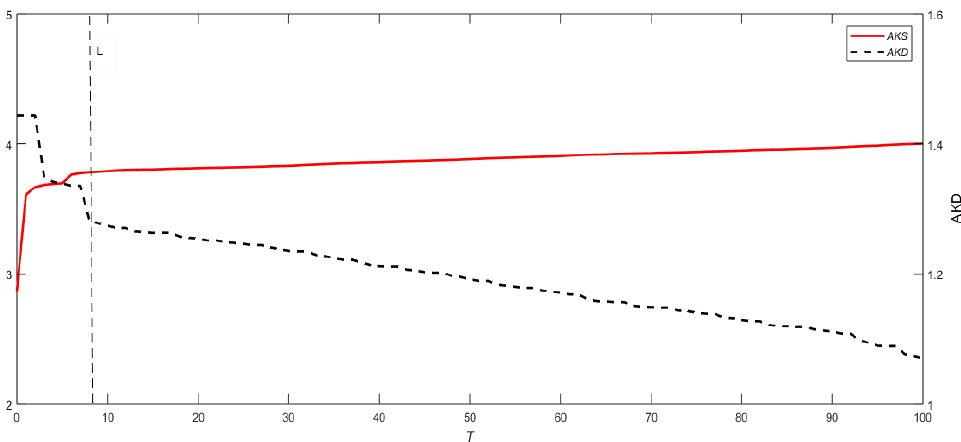
Figure 2. Evolution of AKS and AKD in a collaborative innovation network.